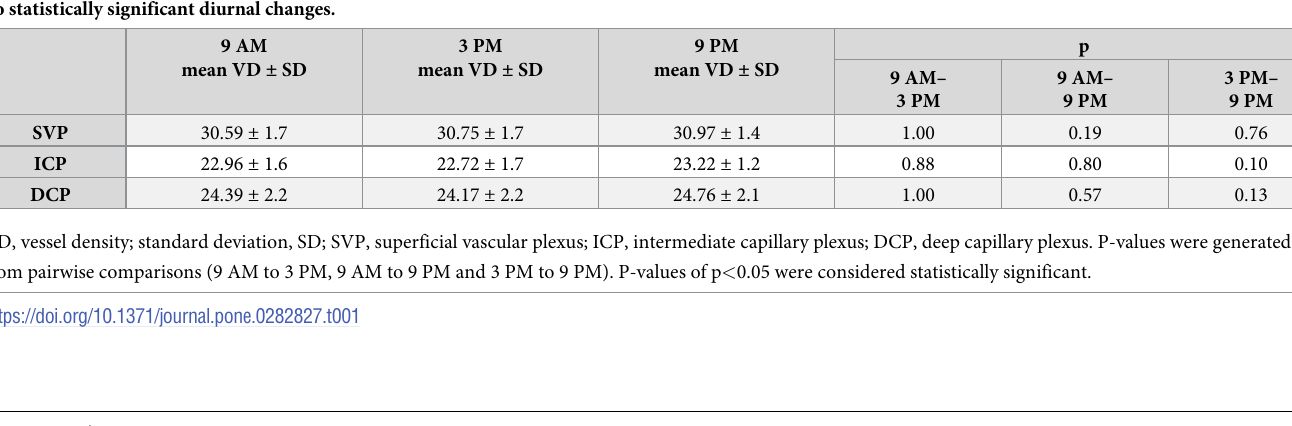
Table 1. Overall mean vessel density with standard deviation for each retinal sublayer at the corresponding time of measurement and respective p-values showing no statistically significant diurnal changes. 9 AM mean VD ± SD